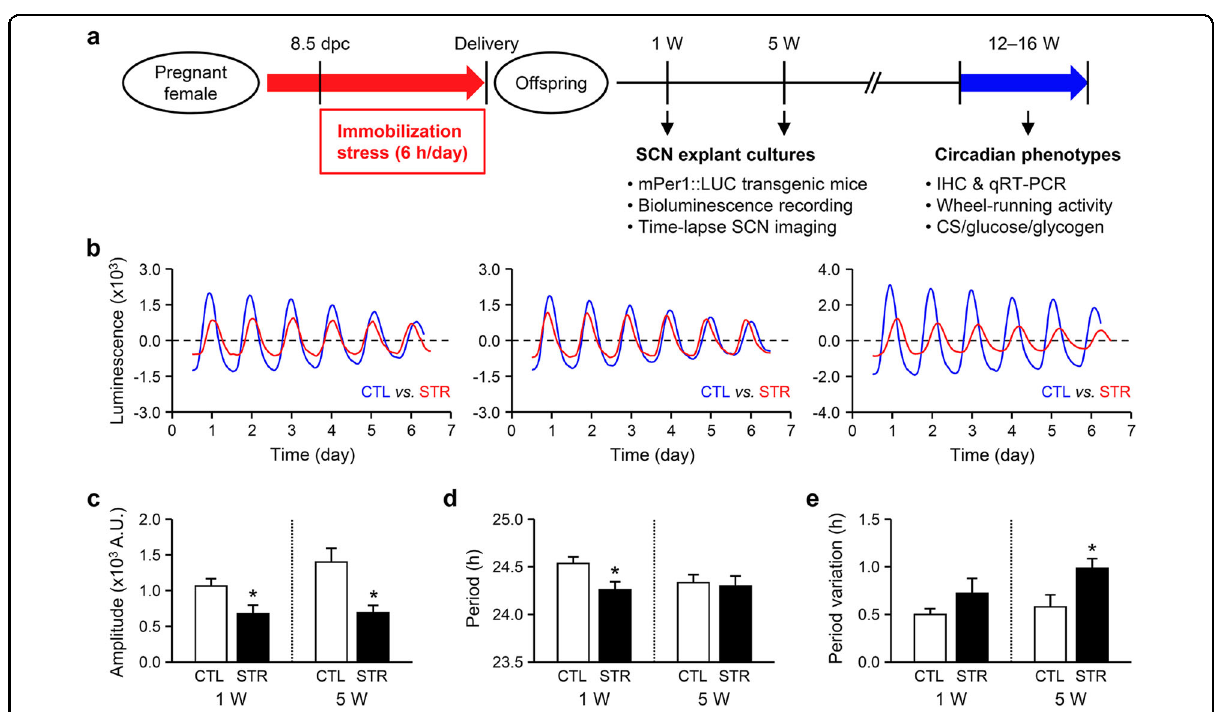
Fig. 1 Effects of maternal stress on the circadian cycling of mPer1::LUC activity in ex vivo SCN explants. a A schematic summary of the experimental procedures. b Representative plots showing detrended traces of circadian bioluminescence signals in SCN explants prepared from 1- week-old control (CTL, blue) and maternally stressed mice (STR, red). The starting point in each plot represents 30 min before the fi rst trough. c – e Effects of maternal stress on the amplitude ( c ), period ( d ), and periodic variation ( e ) of circadian mPer1::LUC activity in SCN cultures prepared from 1- (1 W; left) or 5-week-old (5W; right) mice. The standard deviation (SD) of the peak intervals of each SCN explant was used as an index of period variation. The data are expressed as the mean ± SE ( n = 16 explants prepared from 1-week-old CTL mice and n = 10 explants prepared from 1- week-old STR mice; n = 8 explants prepared from 5-week-old CTL mice and n = 6 explants prepared from 5-week-old male STR mice; * p < 0.05 between groups by Student ’ s t